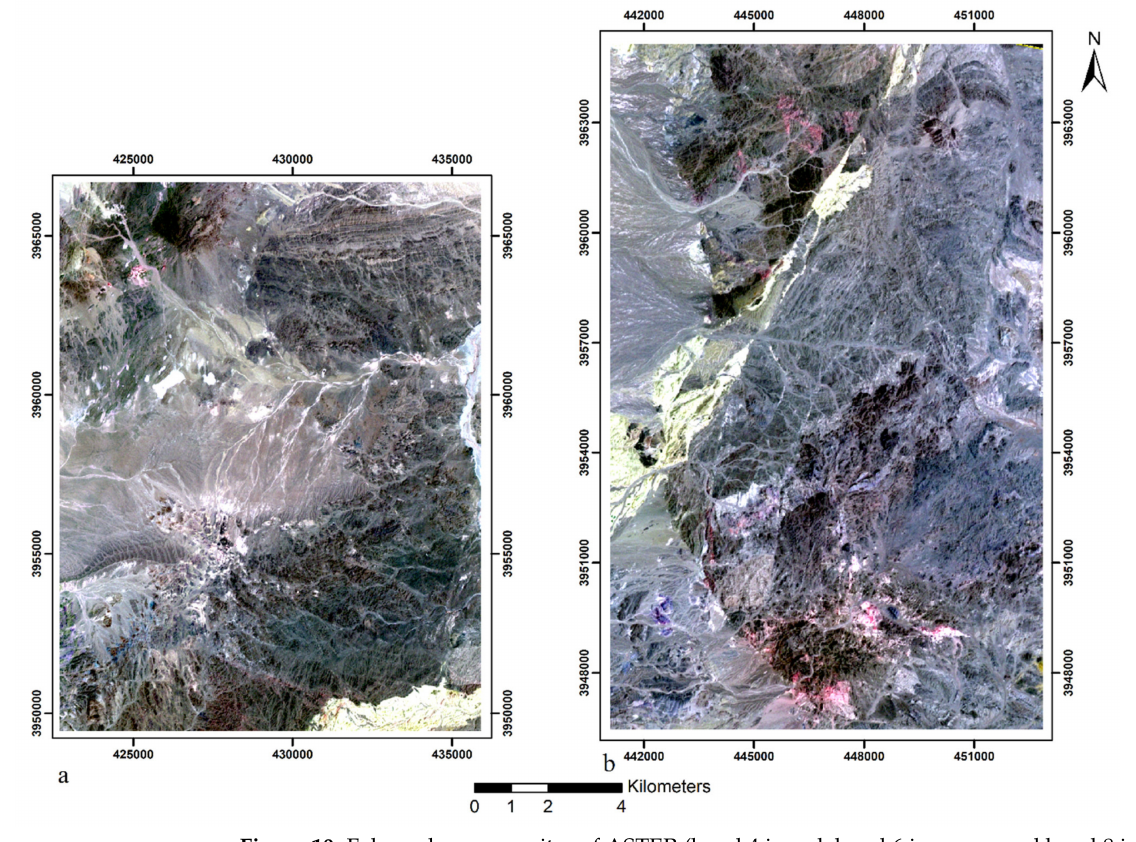
Figure 10. False-color composites of ASTER (band 4 in red, band 6 in green, and band 8 in blue) in ( a ) zone II and ( b ) zone I. Table 3. The logical operator algorithms used with ASTER to map hydrothermally altered rocks in zones I and II (modified after Reference [98]). (b: band; float: floating point; le: less than or equal to; lt: less than; ge: greater than or equal to; gt: greater